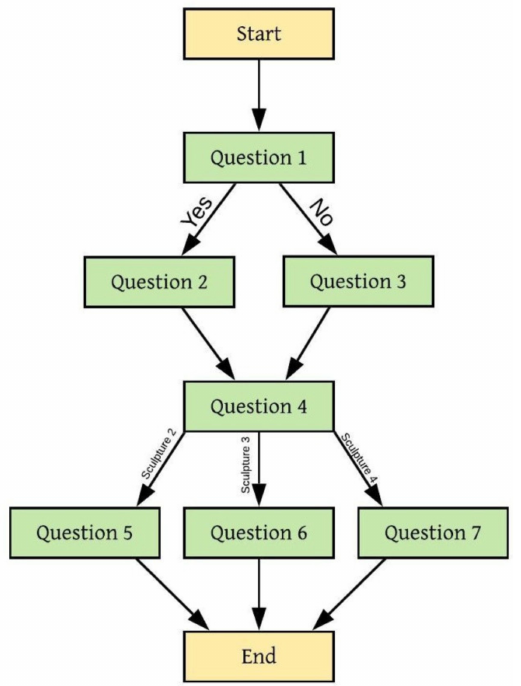
Figure 16. Block diagram of the path through the survey questions.